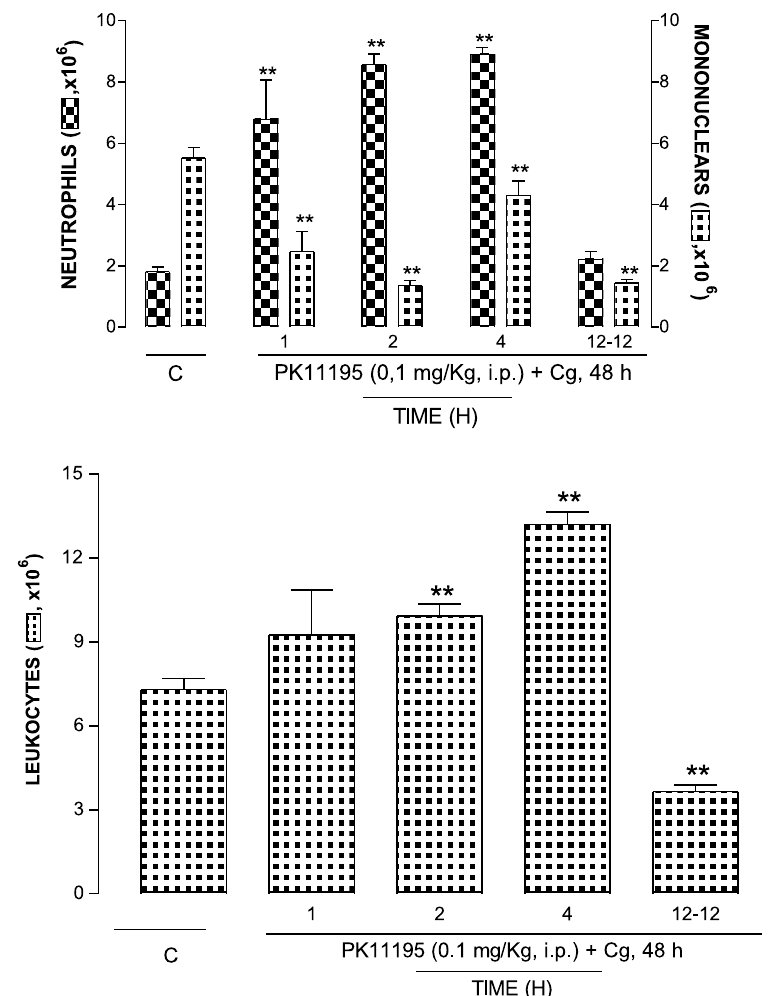
FIG. 3. Effects of PK11195 (0.1 mg/kg, i.p.), administered 1 (cid:1) / 4 h before carrageenan (Cg, 1%/cav.) or twice with a 12 h interval, on the late (48 h) phase of the mouse pleurisy induced by Cg. Leukocytes and exudation levels. Inset: Mononuclear and neutrophil cells, under the same conditions. C, Control responses in animals only treated with Cg. Each column represents the mean of four to six animals, and the vertical bars represent the standard error of the mean. ** p B /